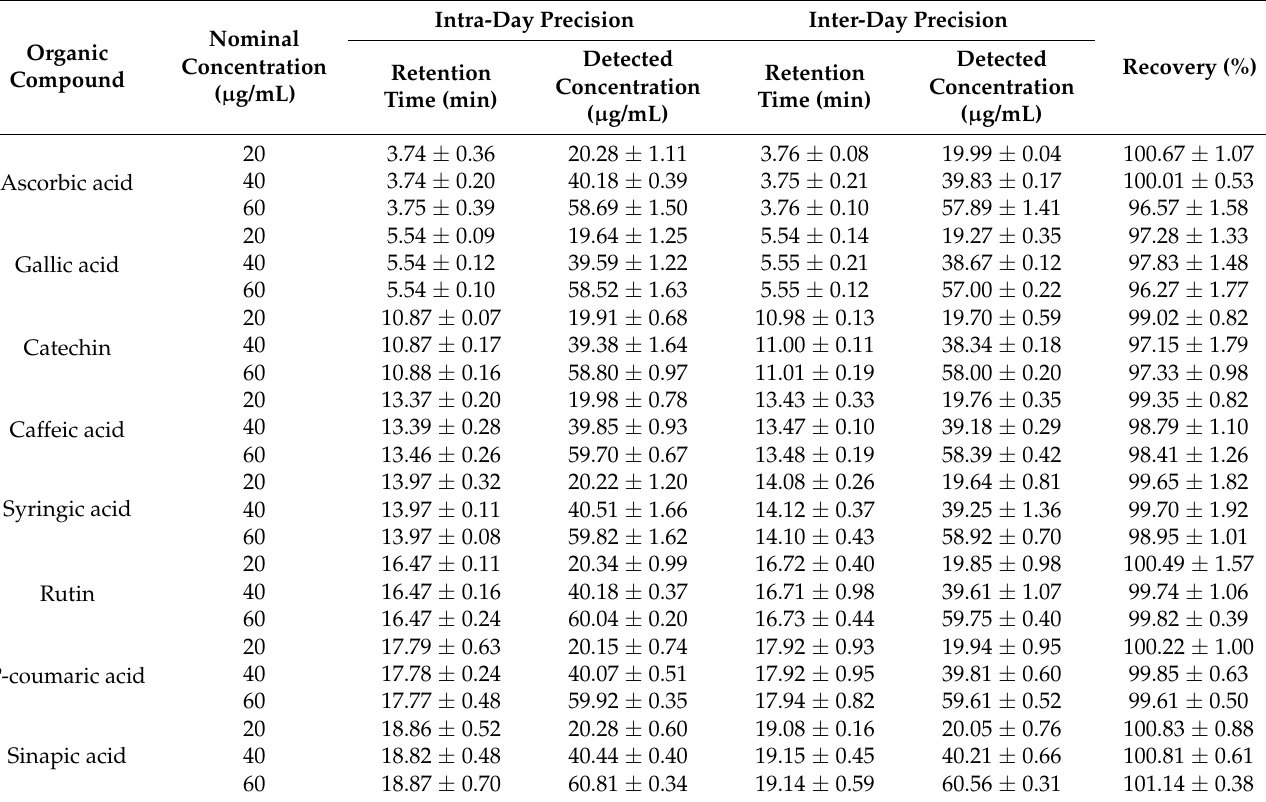
Table 2. Intra- and inter-day precision and accuracy ( n = 10, mean value ±